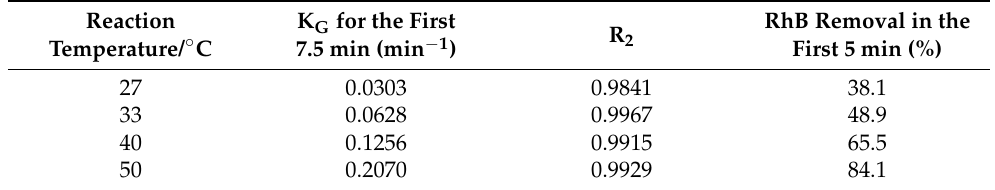
Table 5. The influence of reaction temperatures on k G for the first 7.5 min and RhB removal in the first 5